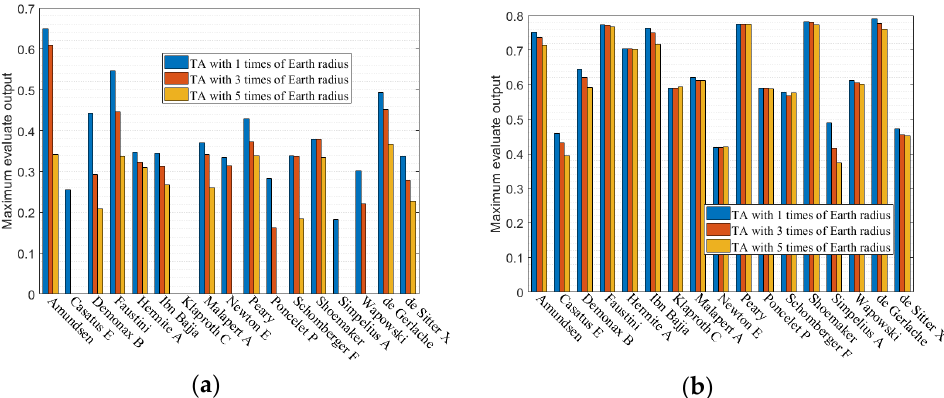
Figure 8. The maximum comprehensive evaluation output with values, i.e., ( a ) 0.01 and ( b ) 0.2, of maximum tolerable sunlight.